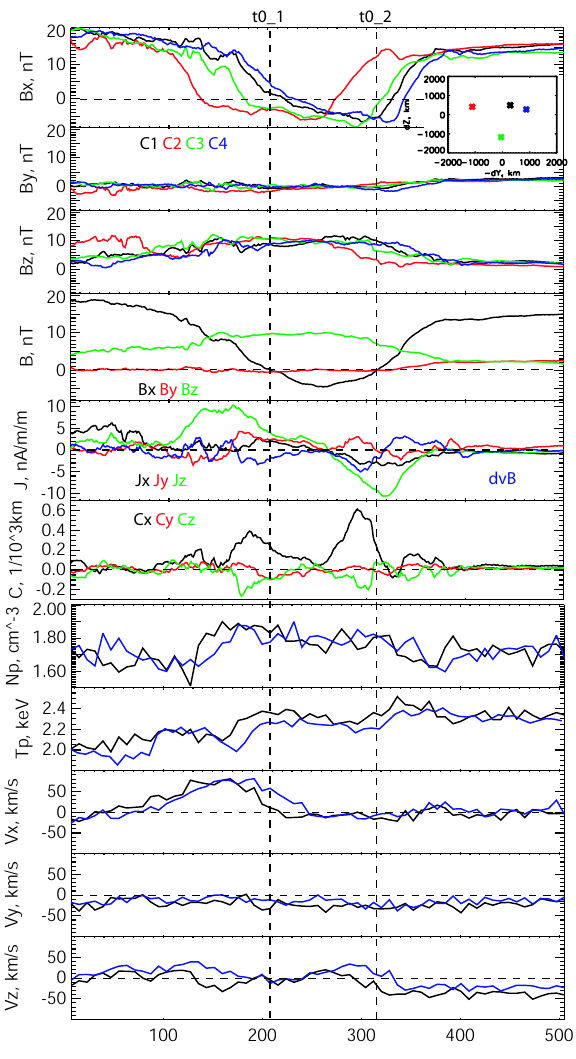
Fig. 1. 500 s of Cluster data from ∼ 15:25 UT, 12 August 2001. From top to bottom: B x , B y , B z from all four spacecraft; three components of B at the Cluster barycentre; three components of the calculated current density j ; X-,Y-, and Z-components of the magnetic field curvature vector C = ( b ·∇ ) b ; H + density, pressure and bulk velocity (three components) from Cluster 1 and